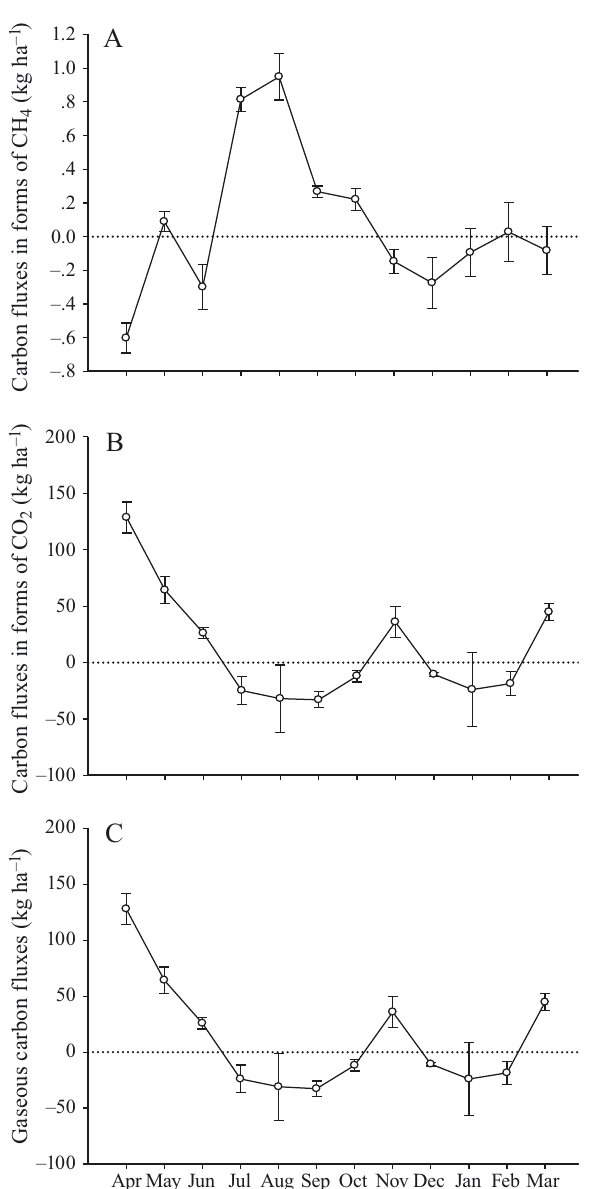
Fig. 3. Monthly cumulative carbon fluxes in the form of (A) CH 4 (CH 4 -C), (B) CO 2 (CO 2 -C) and (C) gaseous carbon in polyculture seawater ponds (PSPs) without feeding. Data are means ±